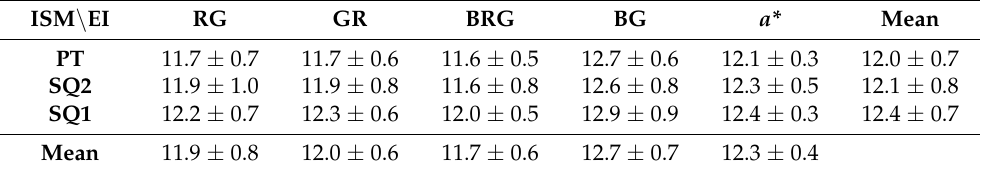
Table 2. Mean and SD of the residuals (absolute values, in %) of linear regression models between visual and optical erythema evaluation, relying on different erythema indices (EI: RG– EI RG , GR– EI GR , BRG– EI BRG , BG– EI BG , and a* ) and image-sampling methods (ISM: PT–60 pixels, SQ2–two small squares, SQ1–one big square).